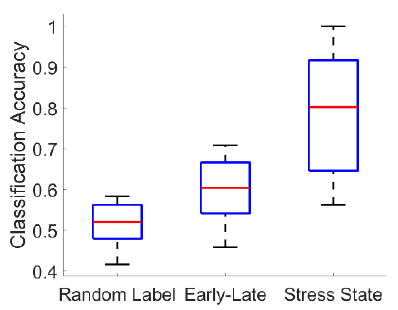
Figure 8. Summary of representative fused-feature classification results. Boxplots show the distribution of classifier accuracies across all 18 subjects for a chance logistic regression classifier formed by randomly permuting the congruent and incongruent labels (“Random Label”); a null logistic regression classifier formed by training to discriminate early versus late segments in congruent experimental sessions (“Early-Late”); and the actual logistic regression stress-state classifier trained to discriminate congruent from incongruent segments (“Stress State ”).